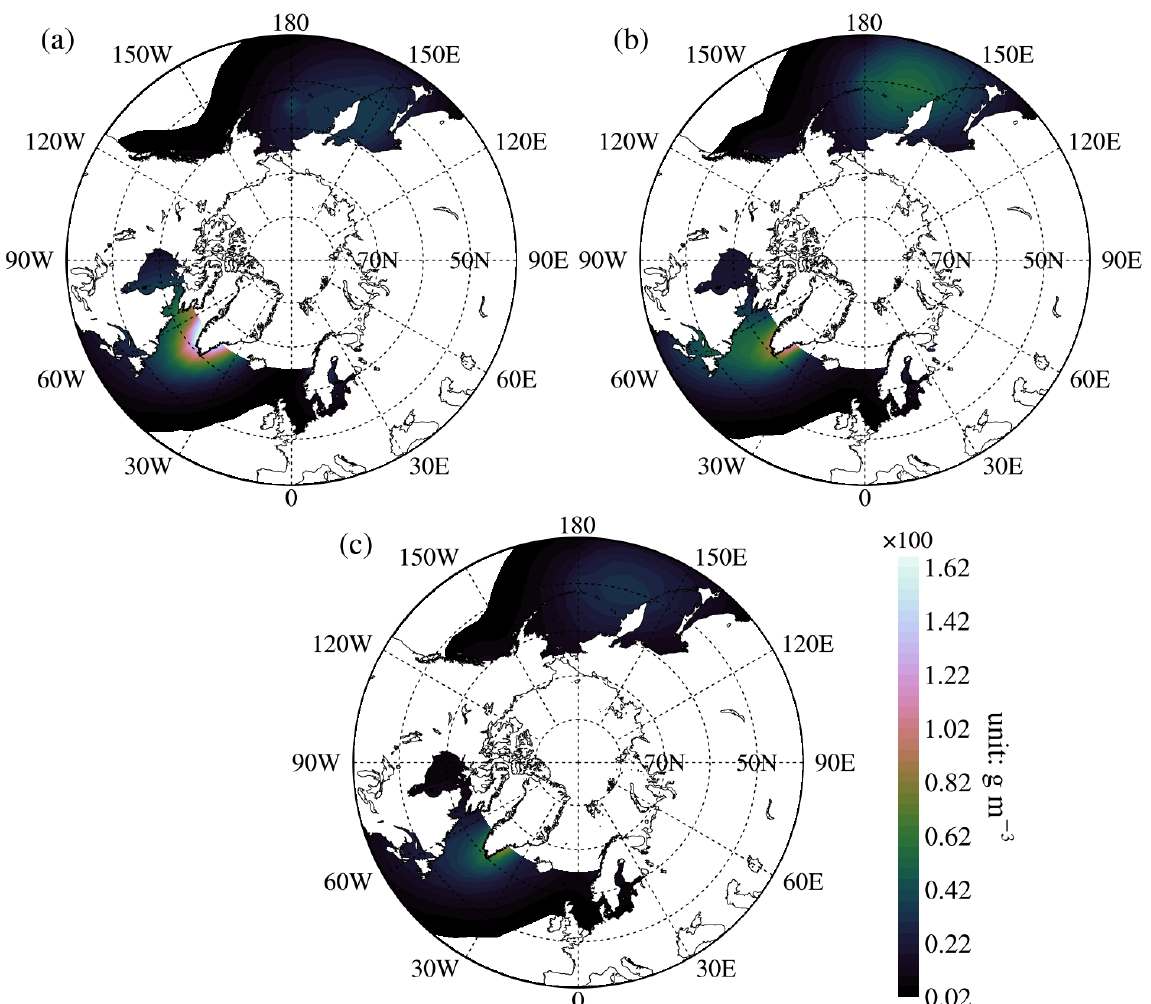
Figure 3. Northern hemisphere annual mean surface snow water content distributions over oceans for the one year of 2016 derived from ( a ) CPR reflectivities, ( b ) DPR reflectivities and ( c ) the GPM 2B combined product. Results are multiplied by 100.